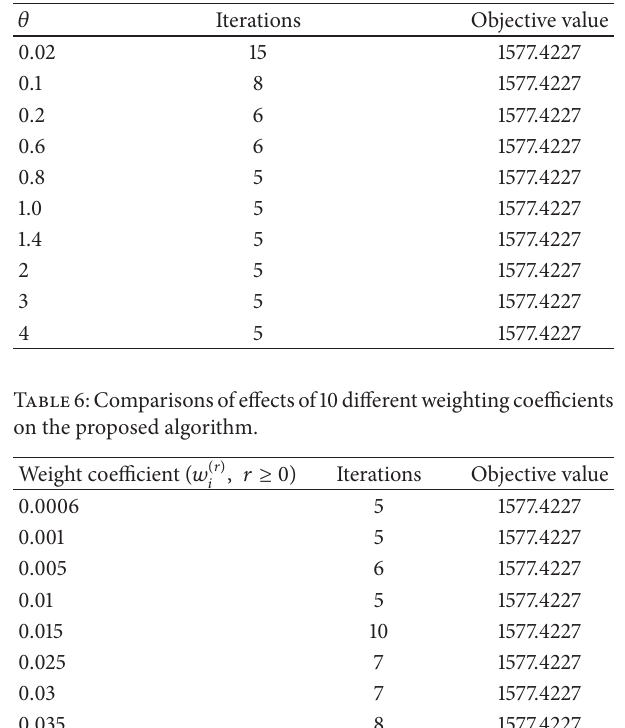
Table 5: Comparisons of effects of 10 different 𝜃 values on the proposed algorithm.